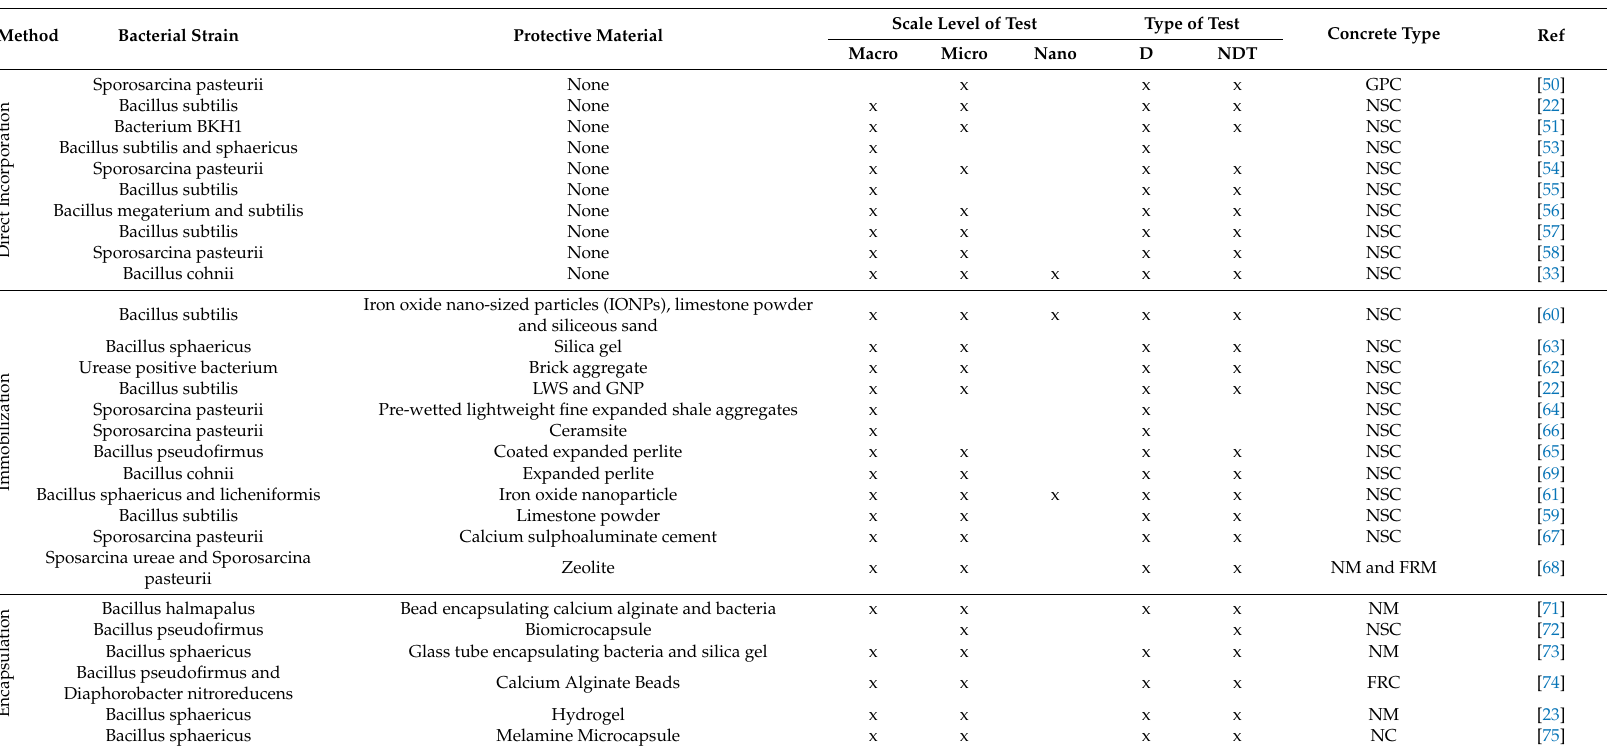
Table 2. Application methods of bacteria in cementitious composites with protective materials and the corresponding property tests.